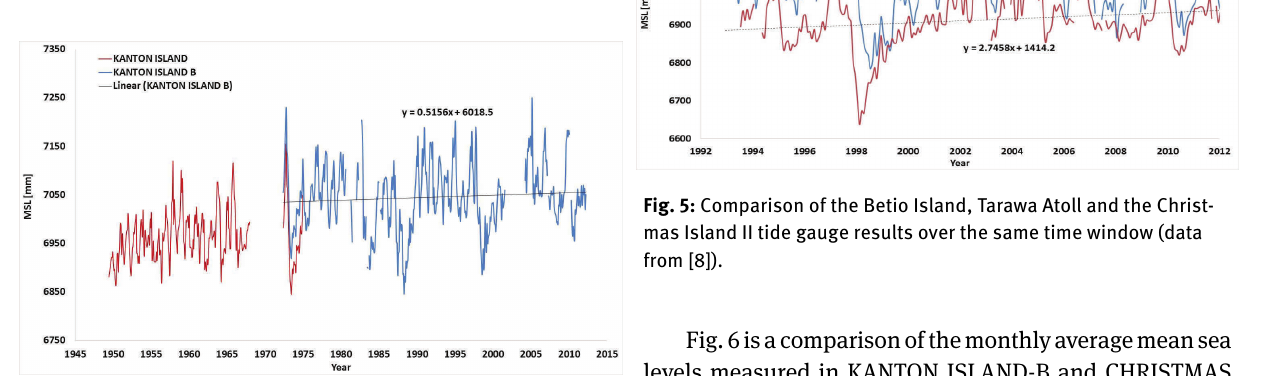
Fig. 3: Kanton Island and Kanton Island B tide gauges (data from [8]).